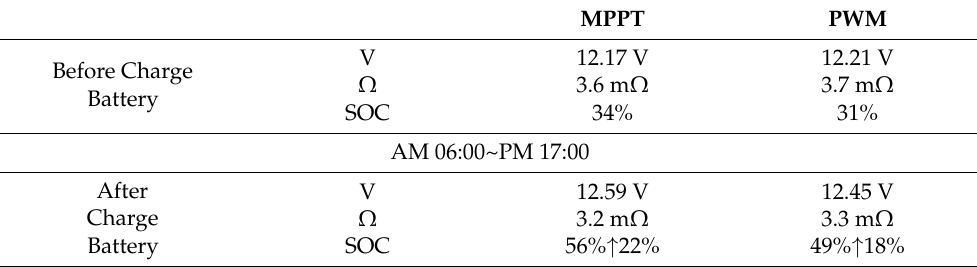
Table 1. Case 1: battery state of charge (SOC) before/after.